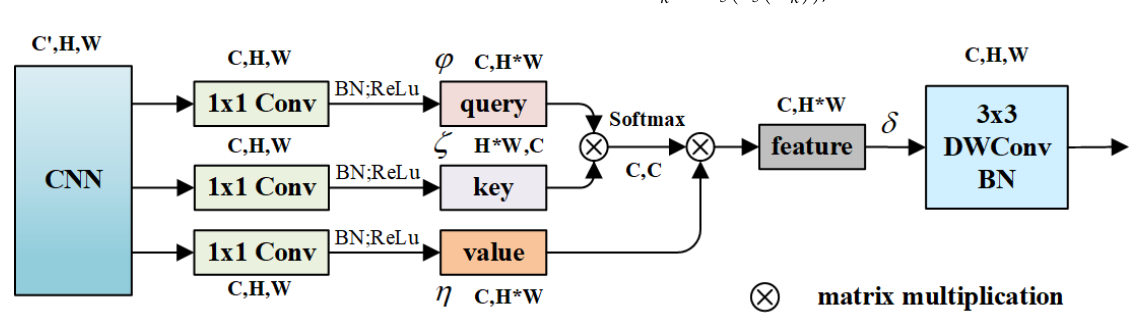
Figure 2. Structure diagram of self-attention feature transfer module. The input convolutional neural network (CNN) of the module corresponds to 16 × down and 32 × down in Figure 1, ϕ , ζ , η are mapping functions respectively, DWConv represents the depth separable convolution, BN represents the Batch Normalization, C is the number of channels, H is the height of the feature map, and W is the width of the feature